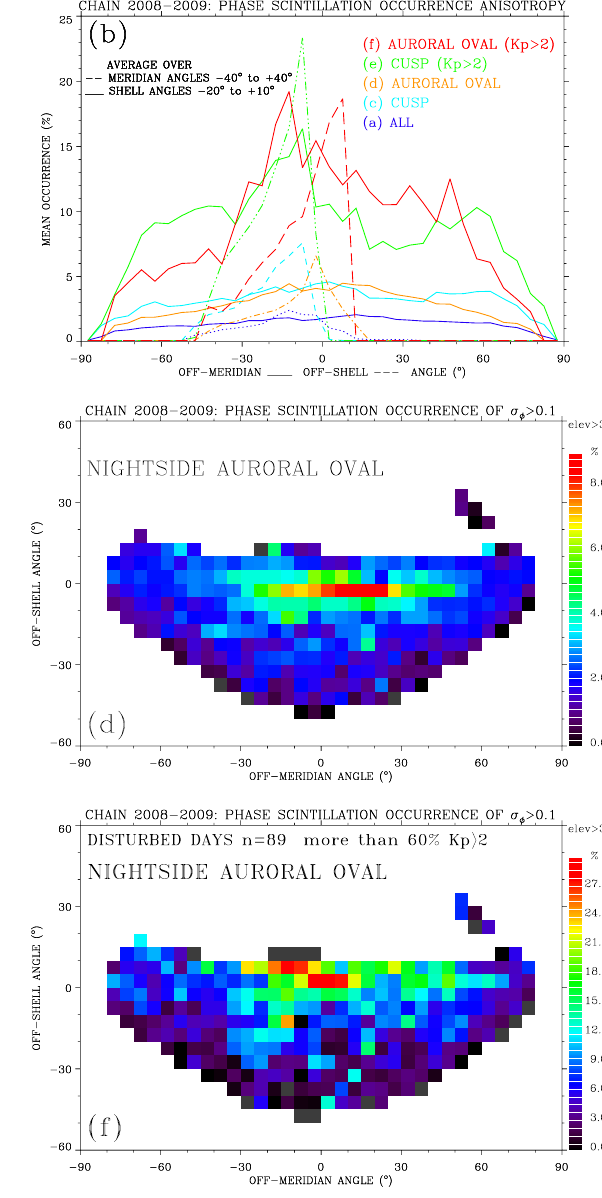
Fig. 11. Maps of phase scintillation occurrence as a function of off-meridian and off-shell angles for data from (a) all latitudes and MLTs combined, (c) cusp sector and (d) nightside auroral oval. The maps for disturbed days are shown for (e) cusp and (f) nightside auroral oval sectors separately. (b) Average scintillation occurrence profiles perpendicularly to magnetic meridian (solid lines) and L-shell (broken lines) are shown for each